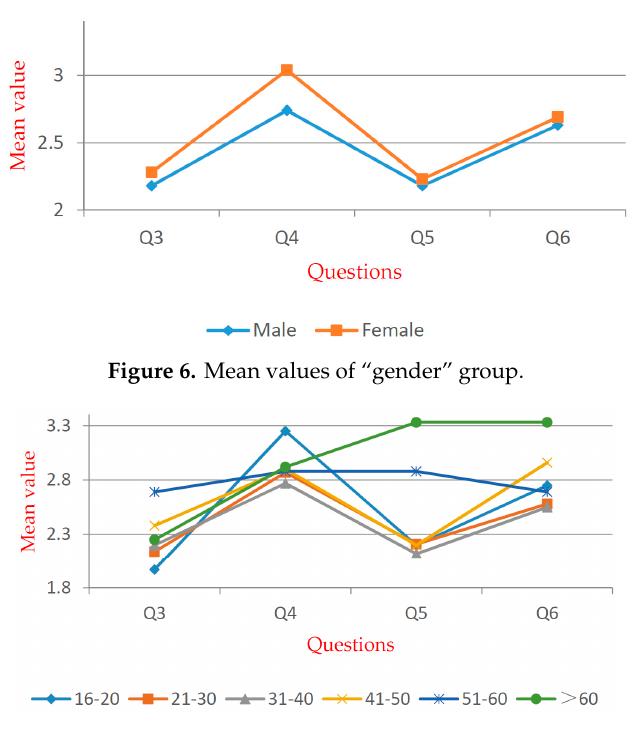
Figure 7. Mean values of “age” group.